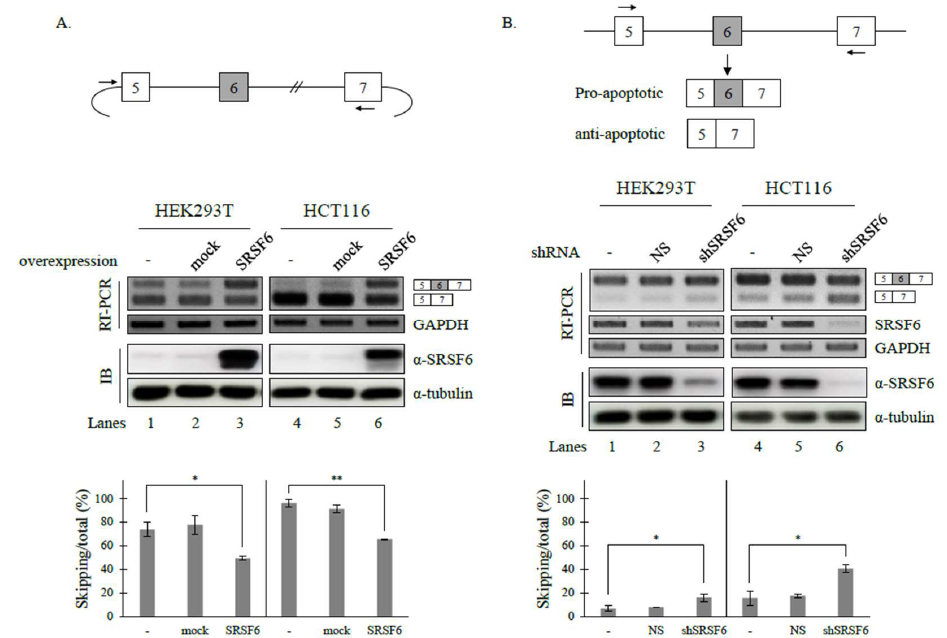
Figure 1. SRSF6 regulates the alternative splicing of Fas pre-mRNA. ( A ) (Upper) Schematic representation of the Fas minigene. Cassette exons are indicated by the gray boxes. Flanking exons are indicated by empty boxes. Introns are indicated by lines. Vector sequences of the minigene are indicated by arcs. Primers used in RT-PCR are indicated by arrows. (Middle) RT-PCR analysis of minigenes with RNAs extracted from untreated, control vector-treated (pcDNA3.1) (mock), and SRSF6-overexpressed HEK293T cells and HCT116 cells. GAPDH was used as a loading control. Immunoblotting with anti-SRSF6 antibody for these cells was also performed with α-tubulin as a loading control. (Lower) Statistical analysis graphs of RT-PCR with p values. Standard deviations (SD) calculated from three independent experiments are indicated by error bars: ** p < 0.01, * p < 0.05. ( B ) (Upper) Schematic representation of genomic Fas gene and its alternative splicing products. Exons and introns are indicated by boxes and lines, respectively. Primers used for RT-PCR are indicated by arrows. (Middle) RT-PCR analysis with RNAs extracted from untreated, non-silencing shRNA-treated, SRSF6-shRNA-treated HEK293T, and HCT116 cells with GAPDH as a loading control. RT-PCR and immunoblotting analysis of these cells were also performed with GAPDH and α-tubulin as the loading controls. (Lower) Statistical analysis graphs of RT-PCR with p values. Uncropped figures are shown in Supplementary Figure S2.